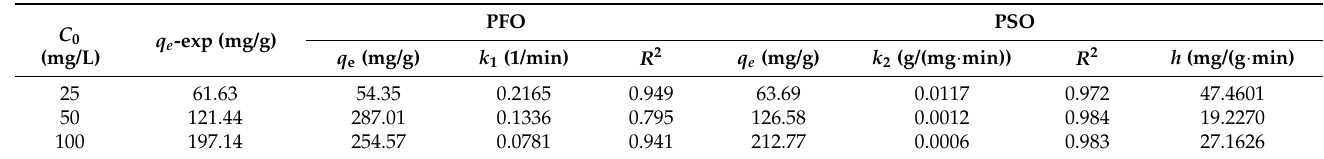
Table 4. Kinetic parameters of pseudo-first-order (PFO) and pseudo-second-order model (PSO). Conditions: adsorbate intial concentration C 0 = 25, 50, and 100 ppm; C 0 volume = 250 mL;